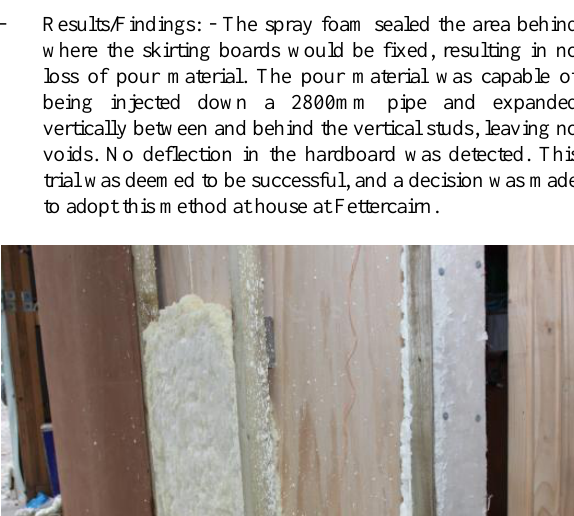
Figure 6. Injection of the foam